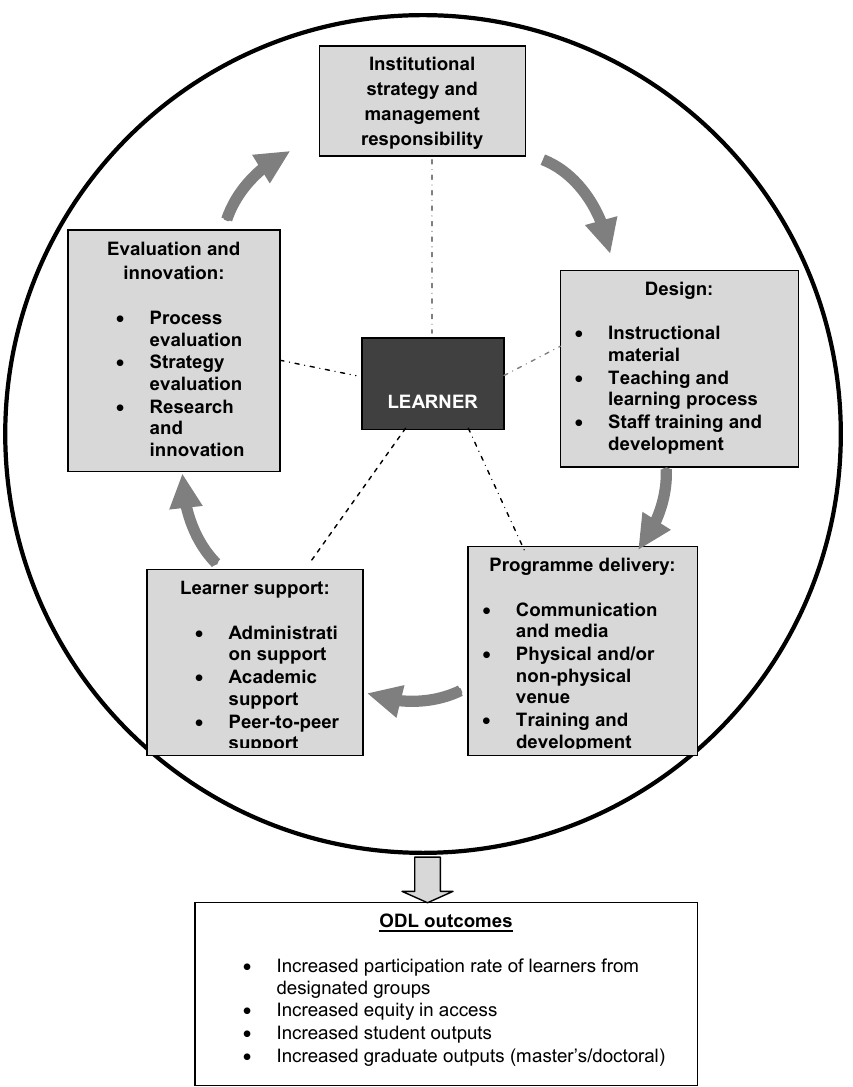
Figure 2 . An illustration of a typical ODL system with its corresponding outcomes.